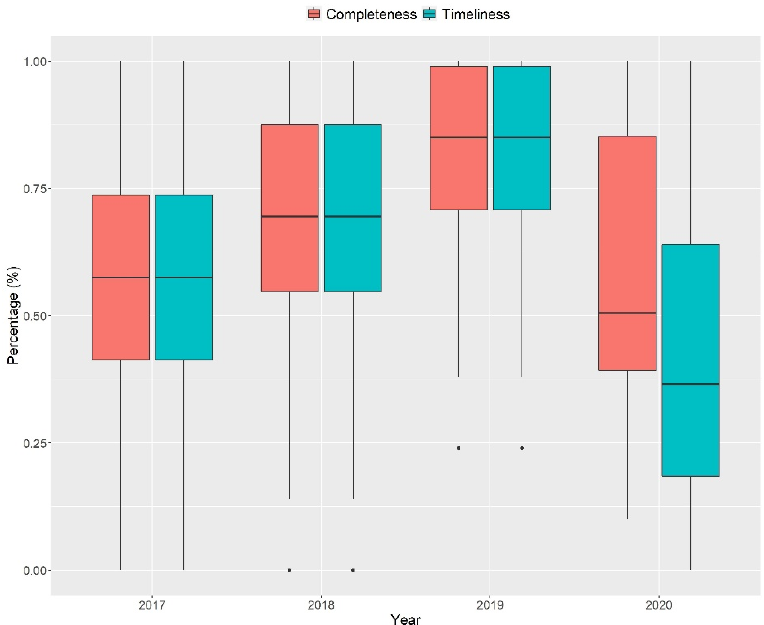
Figure 2. Boxplot of national completeness and timeliness of Indonesia’s EWARS (mean and std. deviation).